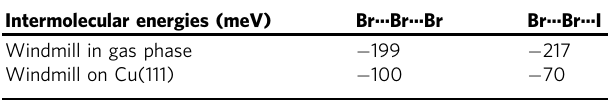
Table 1 Intermolecular energies of Br ∙∙∙ Br ∙∙∙ Br and Br ∙∙∙ Br ∙∙∙ I windmills of bromo- and iodobenzene in gas phase and on